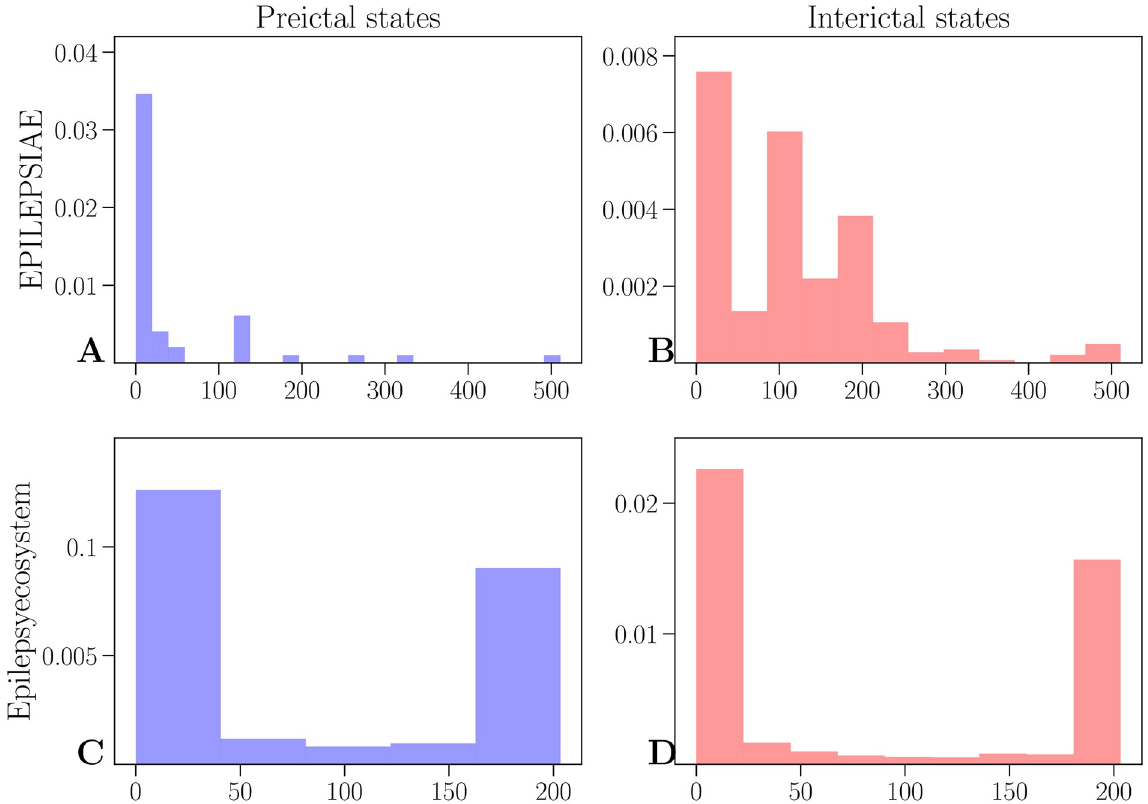
Fig 4. Distribution of maximum of frequency components. Results of the EPILEPSIAE dataset are shown in the upper row for preictal ( A ) and interictal states ( B ). The lower row shows results for the Epilepsyecosystem dataset ( C for preictal and D for interictal states).